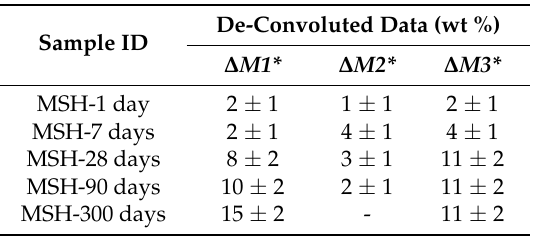
Table 3. Weight loss data at three stages via traditional thermo-gravimetric analysis and using the curve-fitting method.